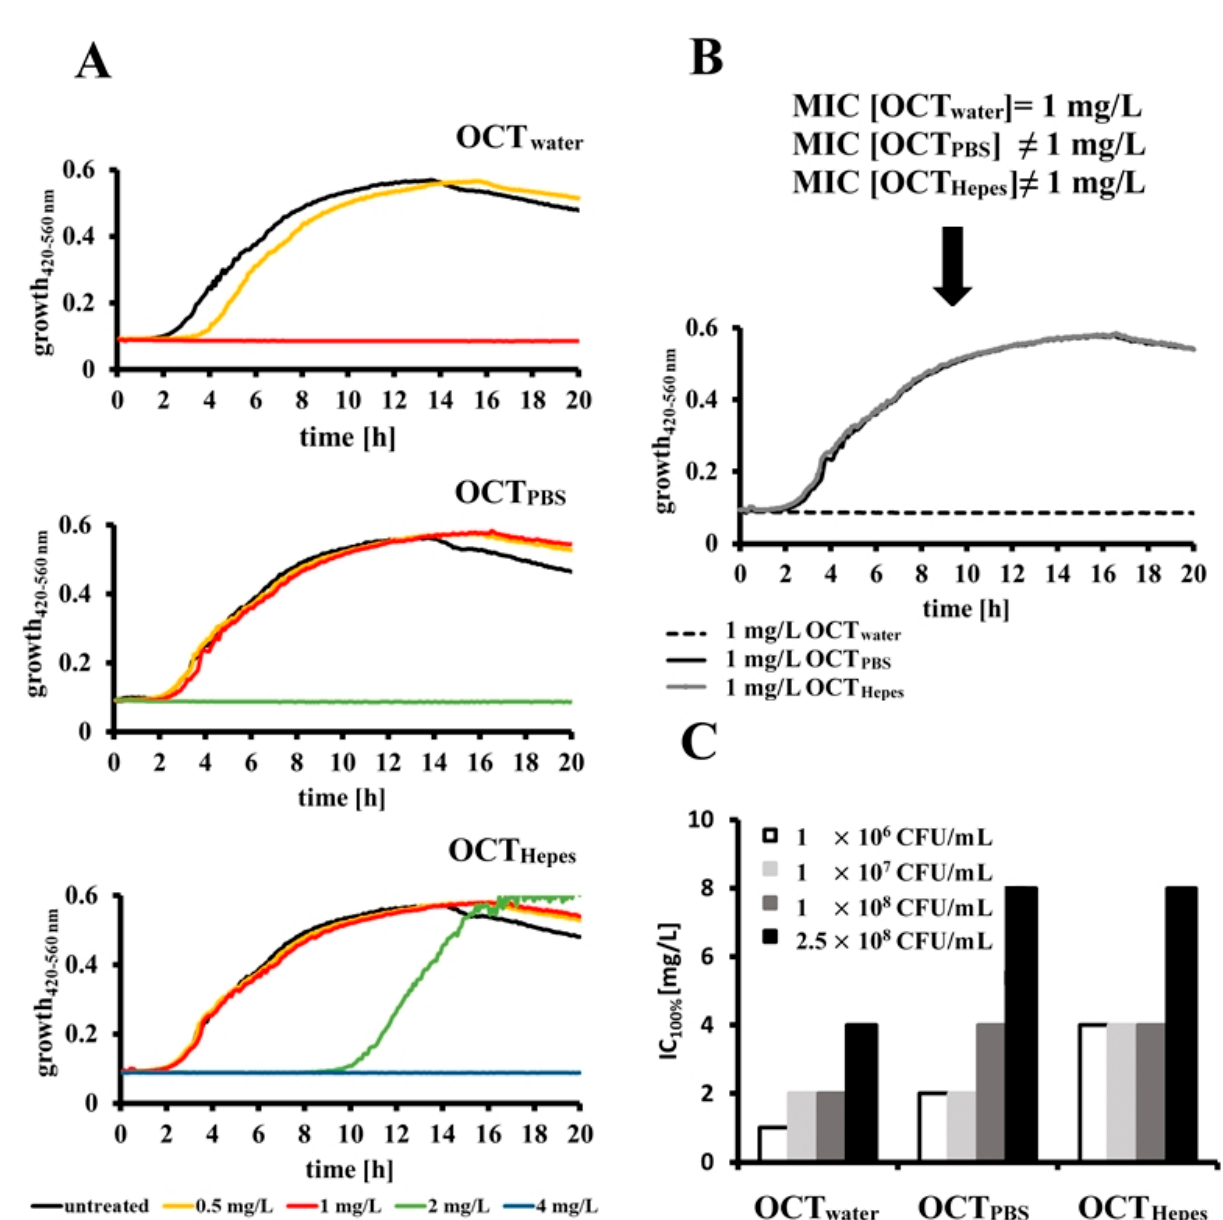
Figure 1. Inhibition of E. coli growth is strongly influenced by OCT solvent and bacterial cell counts. ( A ) Growth curves of 1 × 10 6 CFU/mL E. coli wildtype recorded in presence and absence of the indicated OCT concentrations over 20 h by Bioscreen at 420–560 nm. OCT was dissolved in water (upper panel), PBS (middle panel) or Hepes buffer (lower panel) before being added to the initial bacterial cell suspension. ( B ) Growth of E. coli treated with 1 mg/L OCT dissolved in water (dotted line), PBS (black line) and Hepes buffer (grey line). MIC values represent the lowest concentration of OCT that prevented the growth of 1 × 10 6 E. coli . ( C ) Total inhibitory concentration (IC 100% ) for OCT dissolved in the indicated buffer systems against E. coli of different concentrations ranging from 1 × 10 6 –2.5 × 10 8 CFU/mL, as determined by Bioscreen at 420–560 nm. All results are representative data of at least three independent experiments.